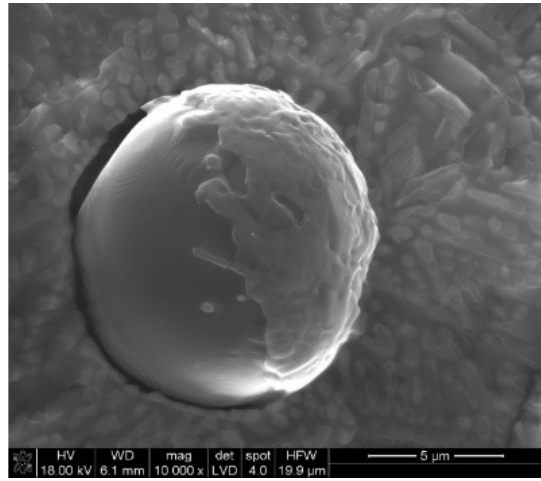
Figure 6. SEM-EDX image of a copper nodule.